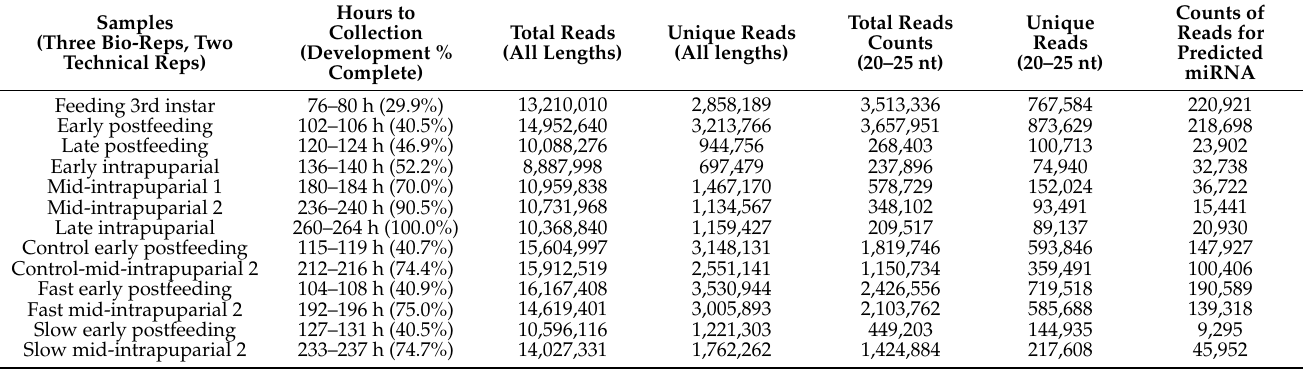
Table 1. Collection and read counts for each C. macellaria sample. Number of Total Reads and Unique Reads for each development point for reads up to 50 nt. Hours for development listed, as well as the percentage of development complete. Numbers for each sample is the sum of the two technical replicates for all three biological replicates (six libraries for each time-point). Distribution of total read counts across read length can be found in Figures S1–S27. Wild-type C. macellaria had an average total development time of 265 h (ranges 234–294 h). Control, and fast- and slow-developing lines collected from Longview, Texas, USA had average development times of 285 (270–293 h), 255 (225–263 h), and 312 (299–334 h) hours, respectively. When the percentage is 100% for late intrapuparial samples, this indicates that some adults had emerged when the samples were